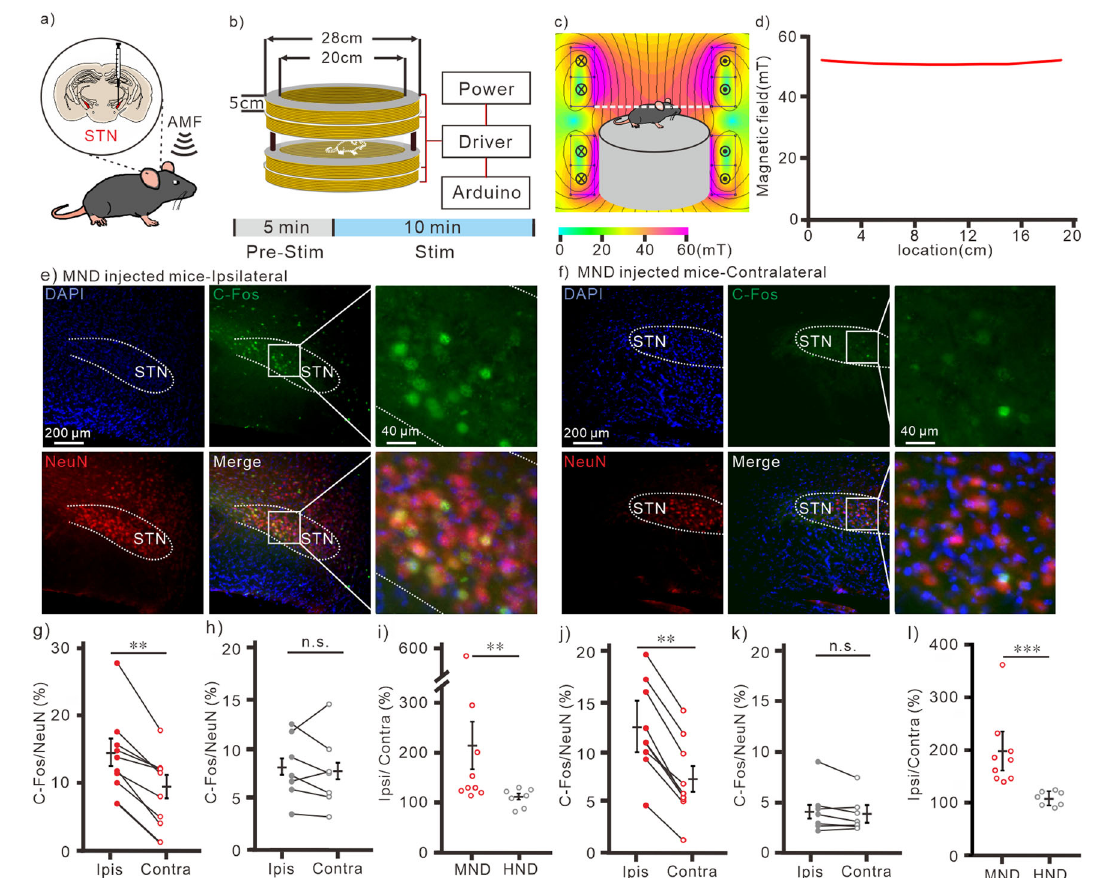
Fig. 7 magnetomechanical stimulation in awake mice in vivo. a Schematic of magnetomechanical stimulation at STN in vivo. Nanodiscs were unilaterally injected into STN. bottom, Timeline of stereotaxic injection, magnetic stimulation and c-fos staining b Schematic of wireless magnetic stimulation apparatus for magnetomechanical stimulation in vivo. bottom, Timeline for magnetic stimulation. c FEMM simulation of the in vivo magnetic apparatus with 10 A current. The black line indicates the cylinder chamber for mice. d Measurement of magnetic fi eld from the white dash line indicates region in c . Immunostaining of NeuN (red), c-fos (green), DAPI (blue), and merged image from ipsilateral STN ( e ) and contralateral STN ( f ) of MND injected mice. g c-fos/NeuN of STN in MND injected mice ( n = 9). h c-fos/NeuN of STN in HND-injected mice ( n = 7). i The difference of c-fos/NeuN between ipsilateral and contralateral STN in nanodiscs injected mice. j c-fos/NeuN of EP in MND-injected mice ( n = 9). k c-fos/NeuN of EP in HND-injected mice ( n = 7). l The difference of c-fos/NeuN between ipsilateral and contralateral EP in nanodiscs injected mice. ** p < 0.01, *** p < 0.001, n.s., no signi fi cance. Wilcoxon signed-rank test for paired data in ( g ), ( h ), ( j ) and ( k ). Mann-Whitney test for unpaired data in i and l . Error bars represent mean ± Nanodiscs characterization . Nanodiscs in chloroform were dried in a vacuum desiccator and then dissolved in ddH 2 O. The aqueous nanodiscs were placed on a copper grid (Ted Pella Inc.) and used transmission electron microscopy (TEM) for visualizing the morphology of the discs. TEM was performed with HT7800 (Hitachi) by the microscopy core laboratory at Chang Gung Memorial Hospital (CGMH). Diameter and thickness of nanodiscs were measured by ImageJ from TEM image, each hexagonal nanodiscs were drawn three diagonals and chose the longest distance as one nanodisc diameter measurement. Nanodisc powders were detected by X-ray diffraction (XRD) to con fi rm the structure of materials. XRD was performed with XtaLAB Synergy DW (Rigaku) by the Instrumentation Center at National Tsing Hua University (NTHU). Hematite or magnetite were mixed with N-grease (Apiezon) and collected on MicroMeshes TM (MiTeGen) coupled to HyPix-Arc 150° curved Hybrid Photon Counting X-ray detector with graphite- monochromated Mo K α radiation ( λ = 0.71073 Å) at 100 K. For studying satura- tion magnetization (Ms) of nanodiscs, vibrating sample magnetometer was used to measure hysteresis curves in the range of± 9kOe. Magnetic moments of nanodiscs were measured with MPMS SQUID Vibrating Sample Magnetometer (VSM; Quantum Design) by the Core Facility Center of National Cheng Kung University (NCKU). Further, an Agilent 725 Inductively Coupled Plasma Optical Emission Spectrometer (ICP-OES) was used to quantify the iron element concentration for the calculation of magnetic moment which was performed by the Instrumentation Center at NTHU. For calculating magnetic moment, we followed the formula